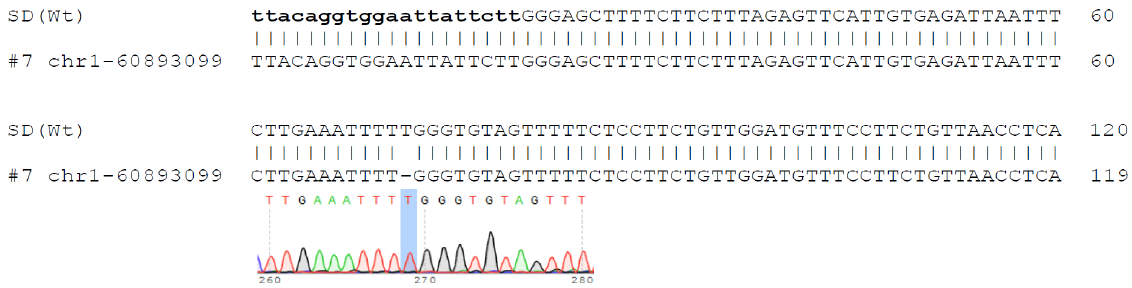
Figure 3: A novel mutation was detected near the COD predicted off-target site at rat Chr1:60893099. Sequencing revealed a novel mutation near the most-likely off-target predicted by COD at rat chr1:60893099. The 1 bp deletion was labelled as “-” in the alignment between the TA-clone of rat #7 and wild type SD rat, and highlighted in the chromatogram. The predicted off-target was marked in lower-cased letters. Detailed sequencing files are included in additional file